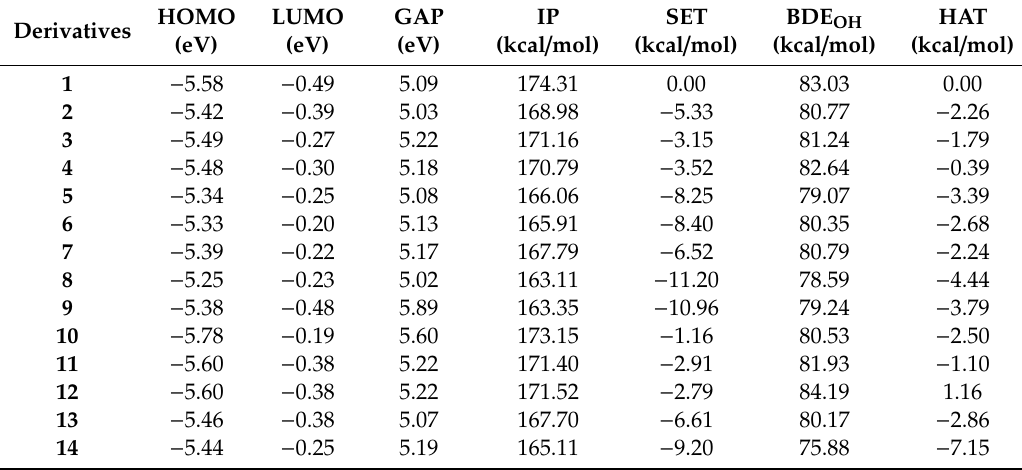
Table1. TheoreticalpropertiesofsesamolandrelatedderivativesusingB3LYP / 6-31 + G(d,p). HOMO:highest occupied molecular orbital; LUMO: lowest unoccupied molecular orbital; GAP: energy difference; IP: ionization potential; SET: single electron; BDE OH : bond dissociation energy of the phenol moiety; and HAT: hydrogen atom